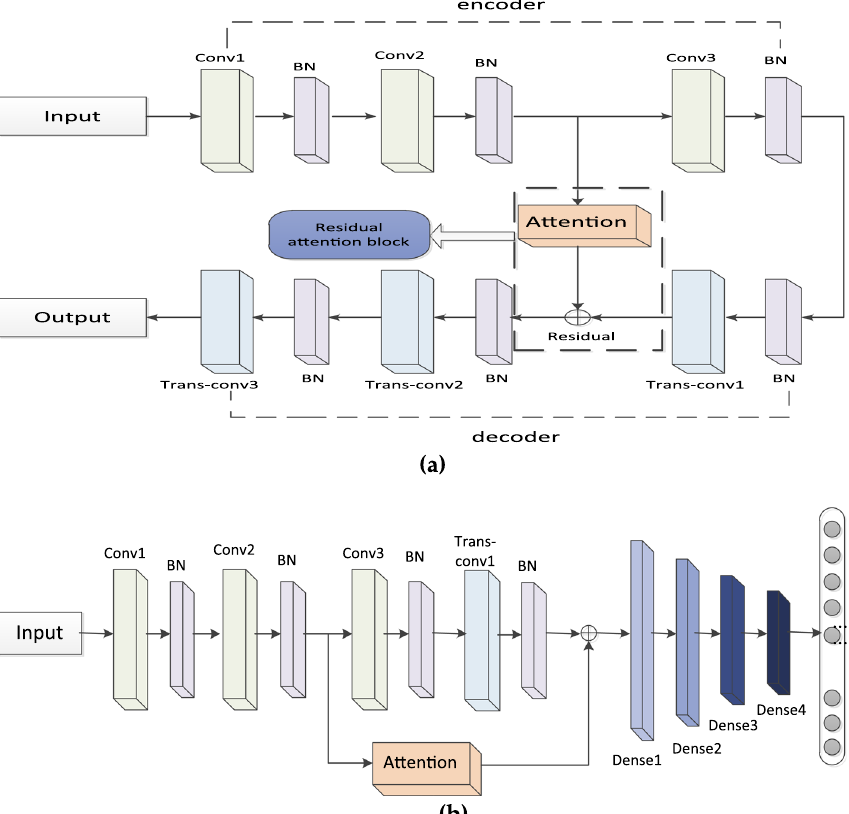
Fig. 3 Underwater acoustic source localization network framework design: a the structure of RA-CAE model; b the structure of RA-CAE-SSL